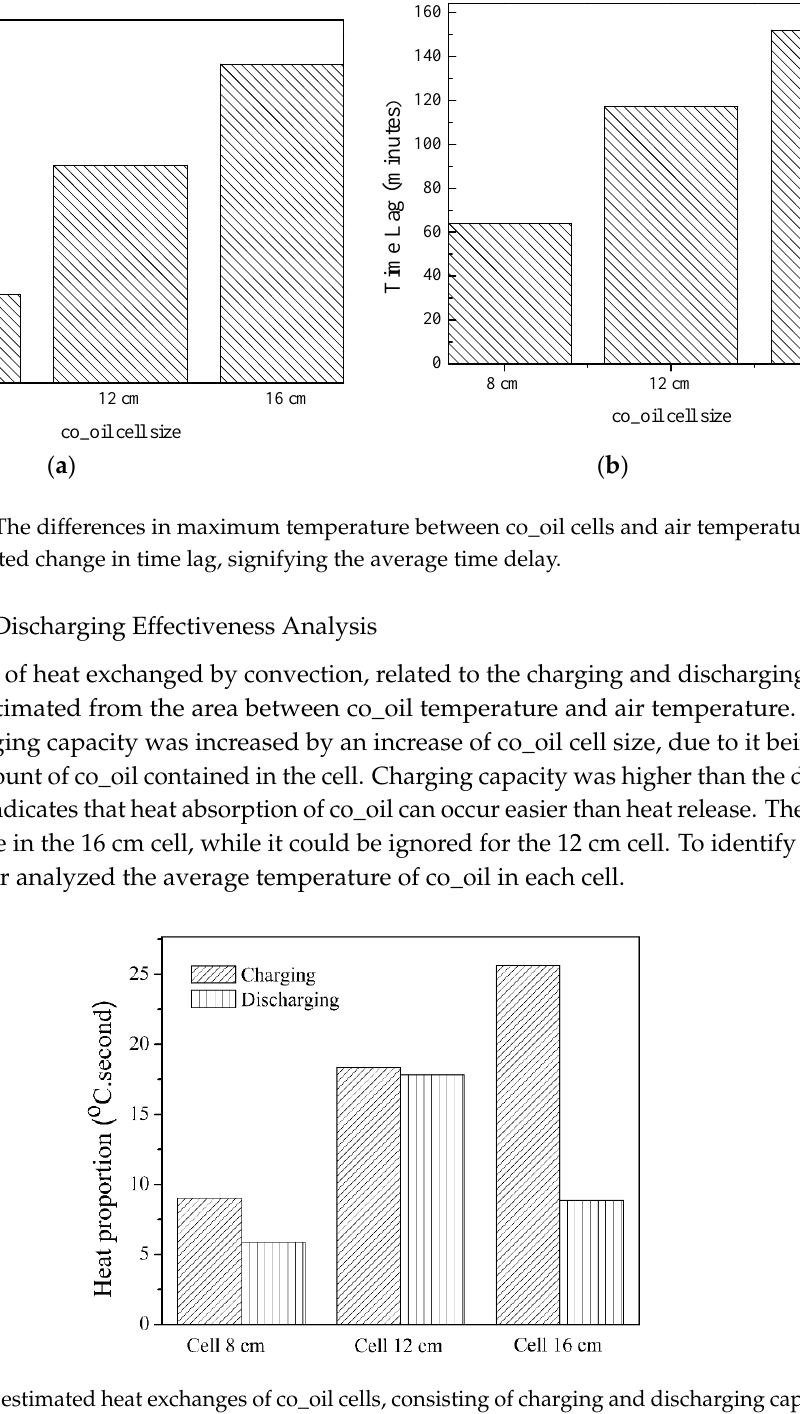
Figure 7. The estimated heat exchanges of co_oil cells, consisting of charging and discharging capability for three different cell sizes.